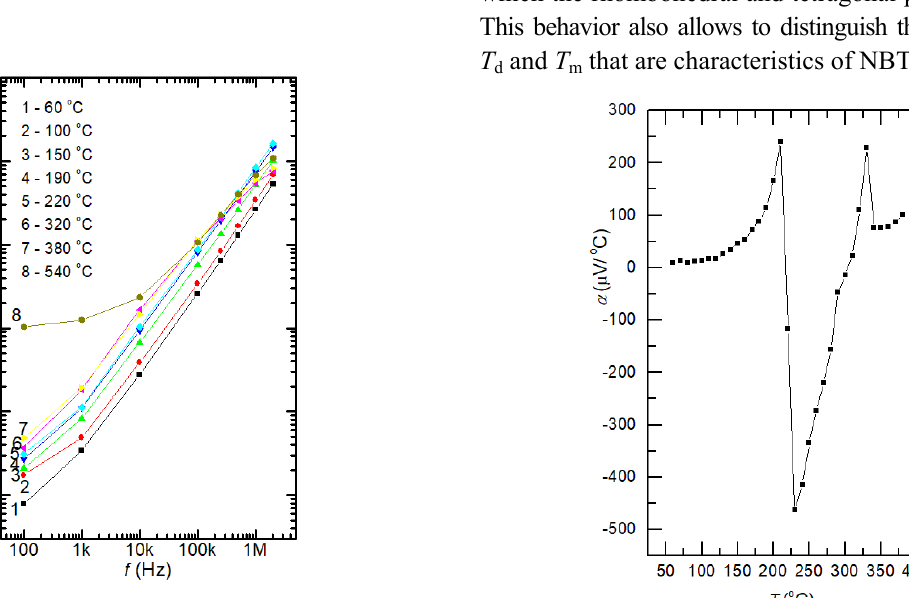
Fig. 7 σ AC of NBT ceramics as a function of frequency at different temperatures. Fig. 8 α of NBT ceramics as a function of